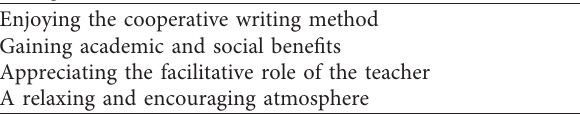
Table 8: Main themes in learners’ attitudes towards collaborative